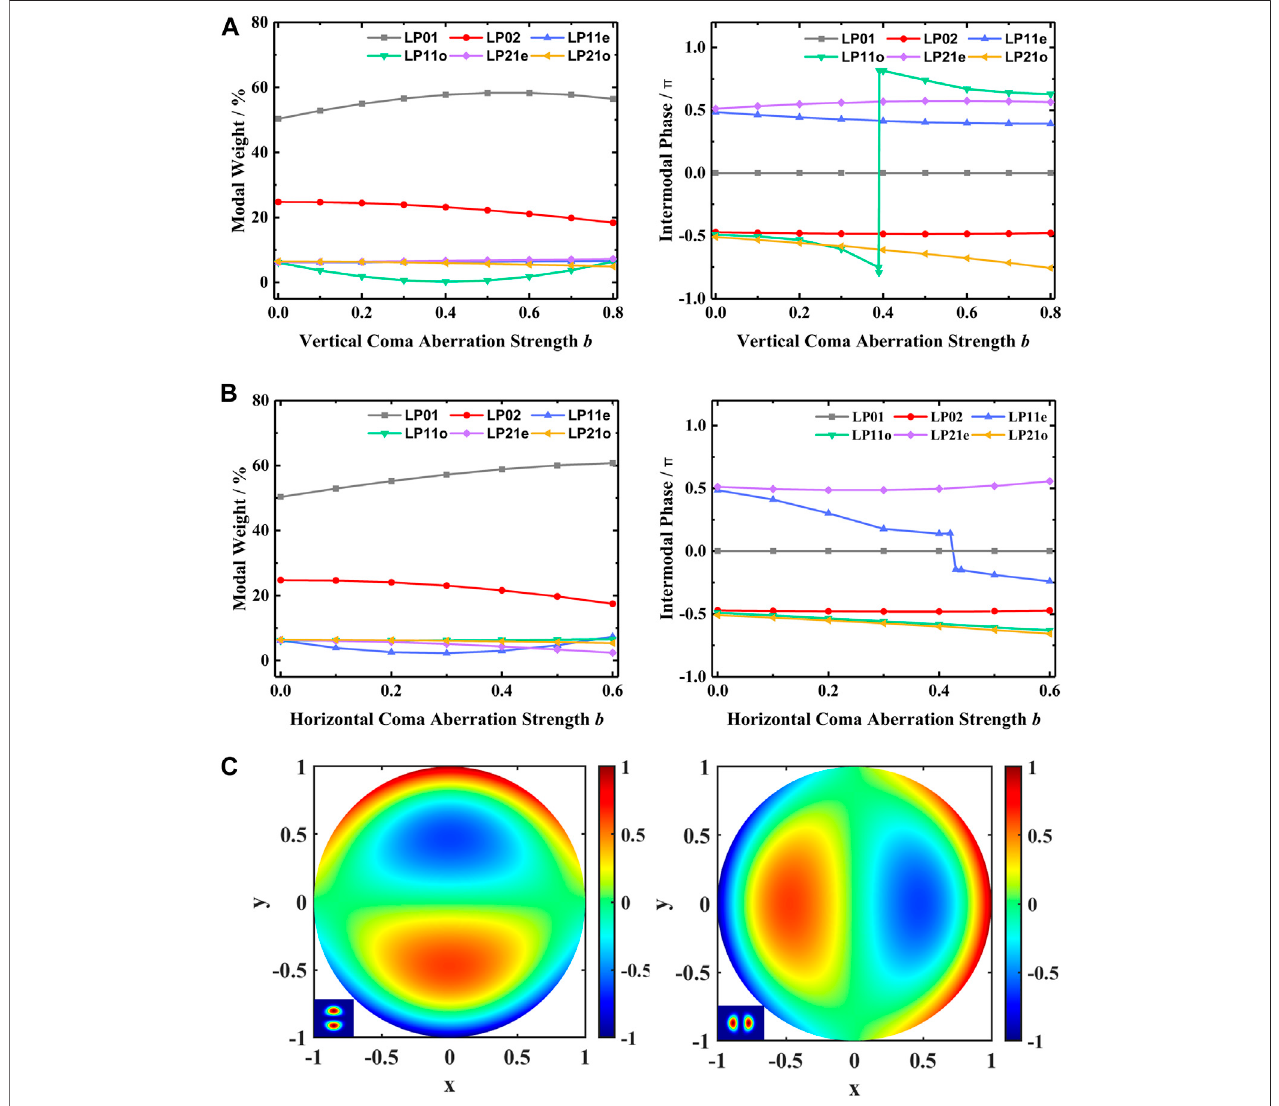
FIGURE 5 | The curves of modal weights and intermodal phases correlated with the aberration strength of (A) vertical coma aberration and (B) horizontal coma aberration. Six modes including LP 01 , LP 02 , LP 11e , LP 11o , LP 21e , and LP 21o are analyzed. (C) Two Zernike terms normalized to unit circle: left, vertical coma aberration (the inserted graph is LP 11o ); right, horizontal coma aberration (the inserted graph is LP 11e ).